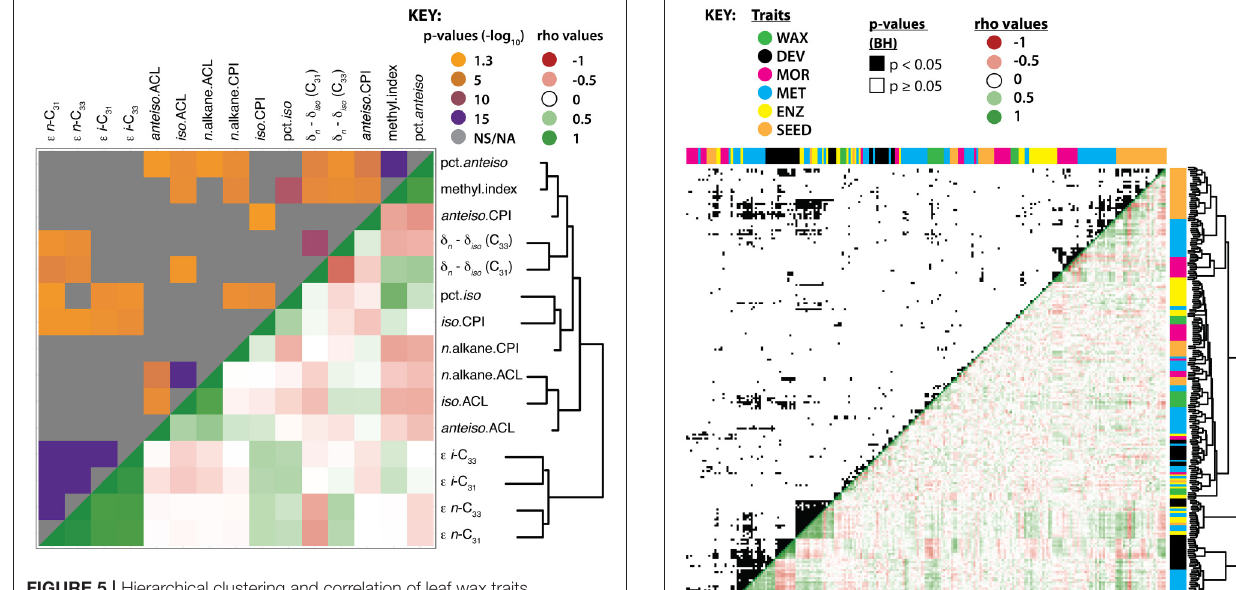
C 31 , but negatively correlated with the δ n – δ iso values of C 33 (see Supplemental Dataset 7 for p and ρ